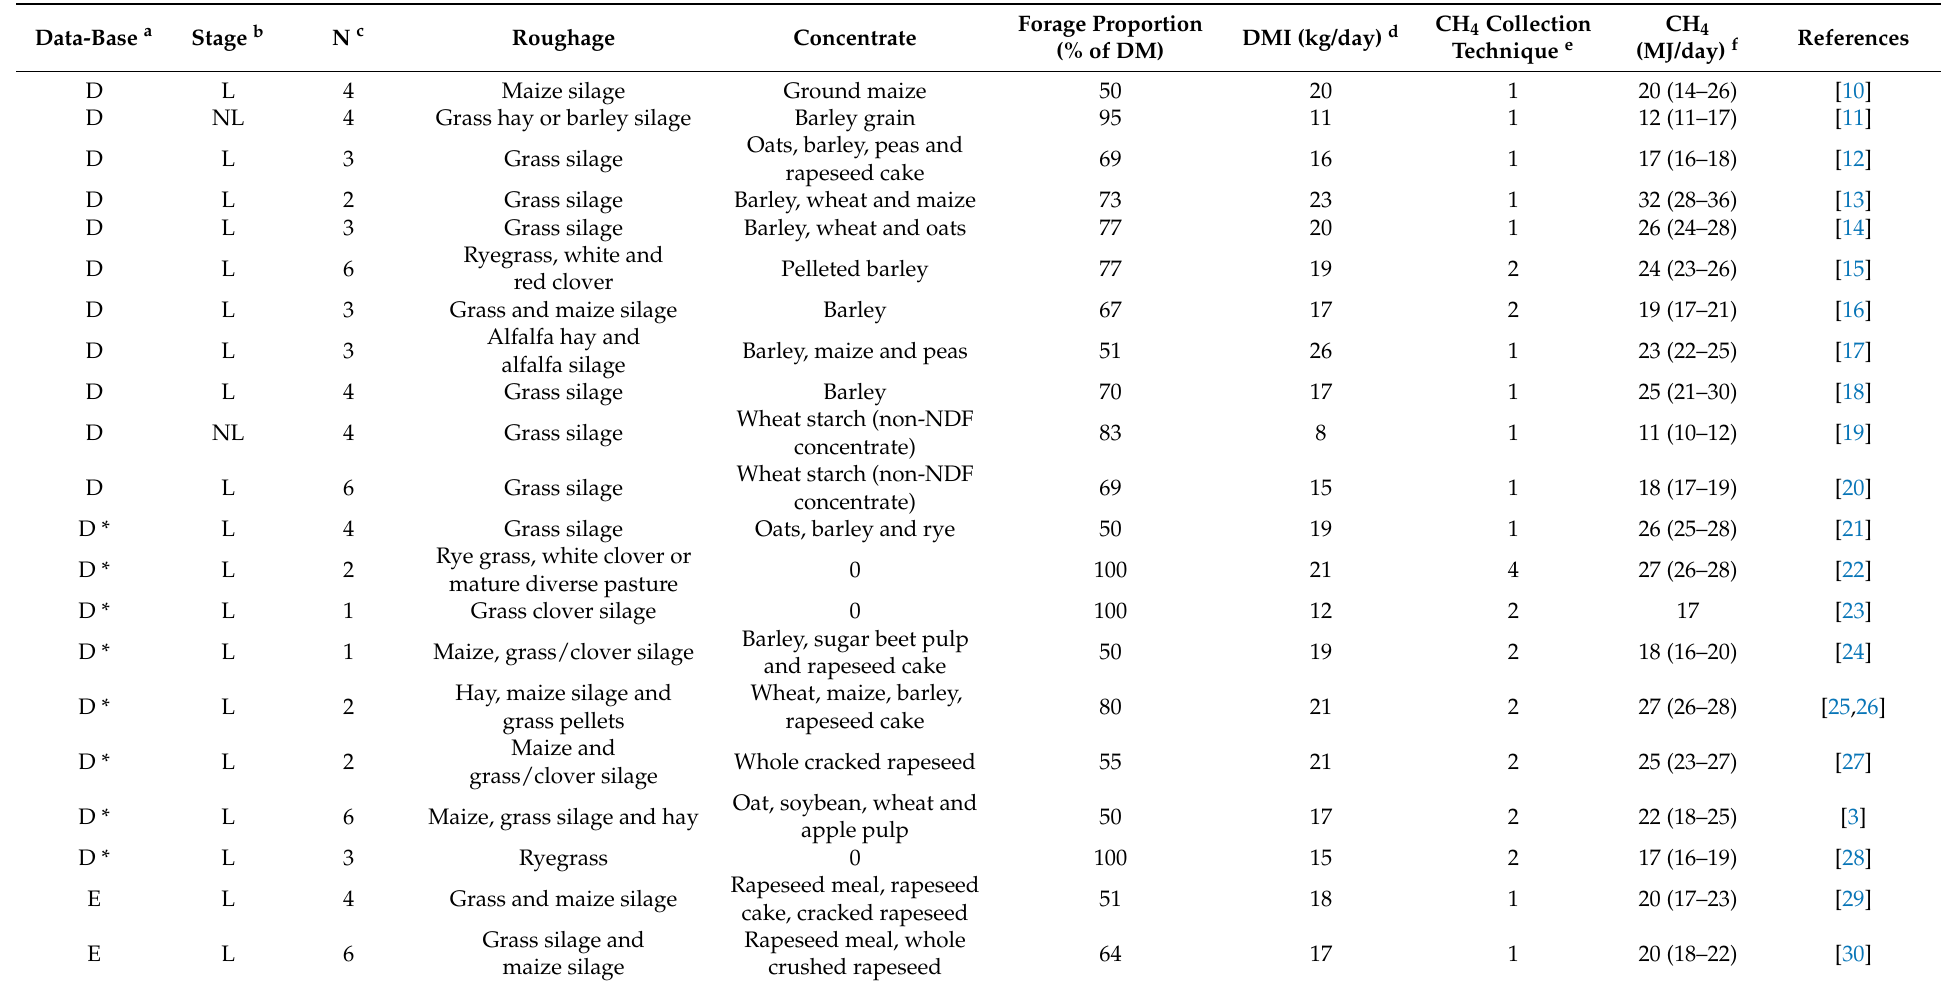
Table 1. Summary of database for the basic